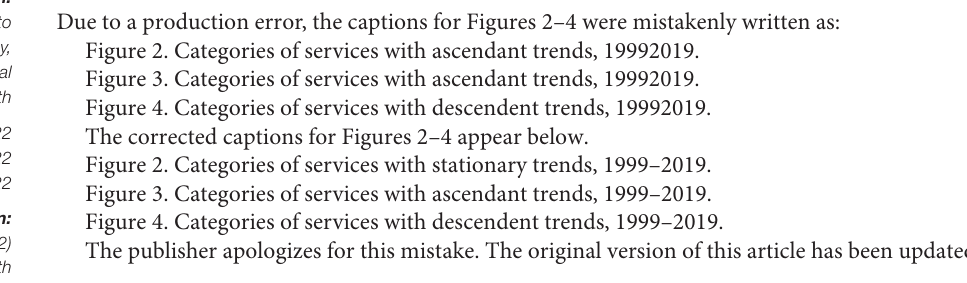
Figure 2. Categories of services with stationary trends, 1999–2019. Figure 3. Categories of services with ascendant trends, 1999–2019. Figure 4. Categories of services with descendent trends,